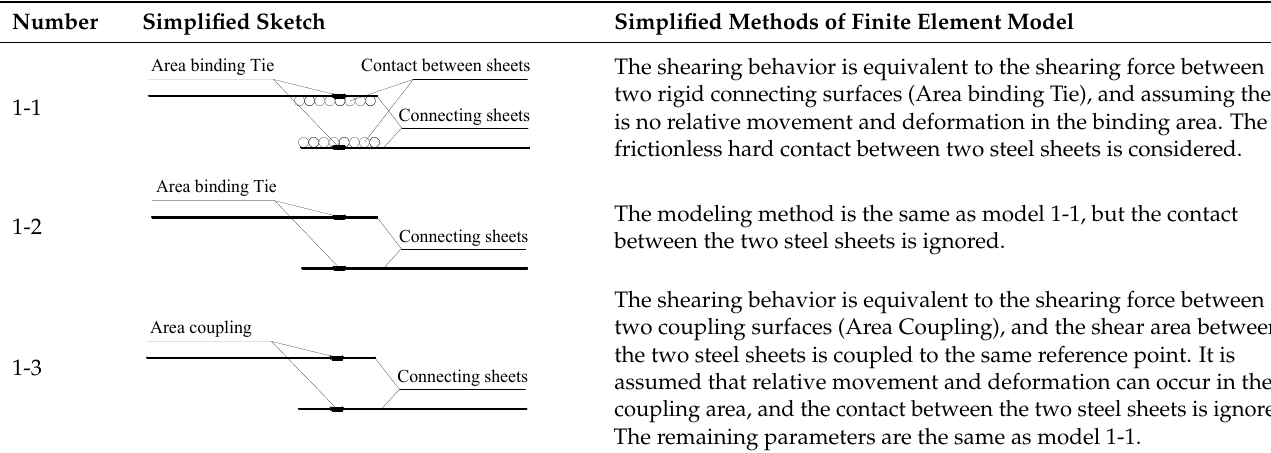
Table 6. The second simplified methods of the finite element model for the SPR joint.